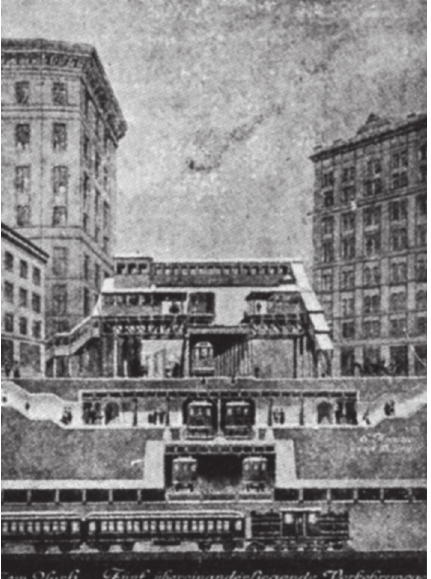
fig. 3. “new York : a street with five levels of railroad and stations” (le Corbusier